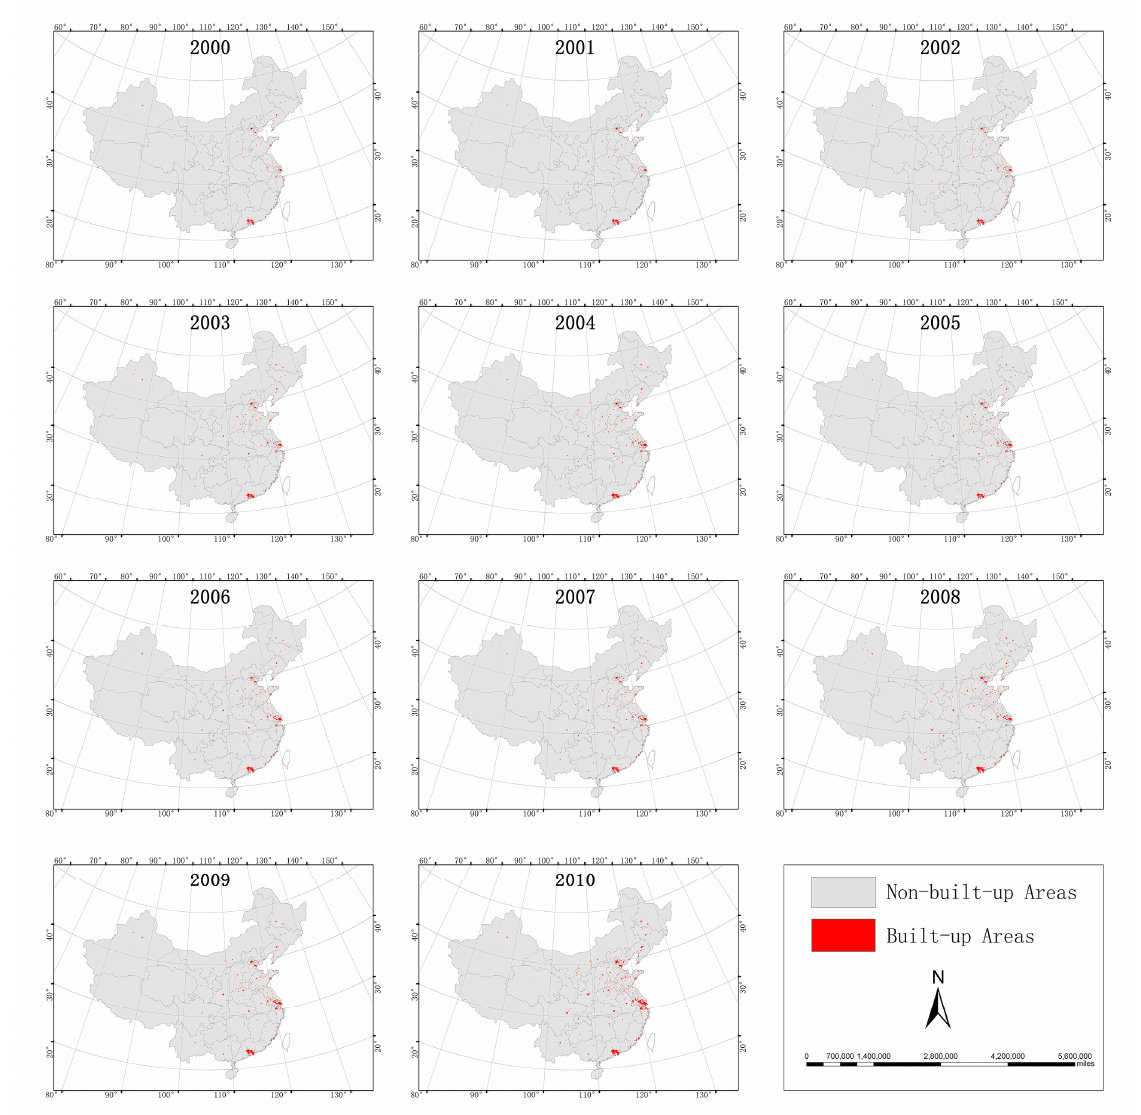
Figure 7. Maps of extracted built-up areas in the selected 31 provinces/municipalities between 2000 and 2010 in